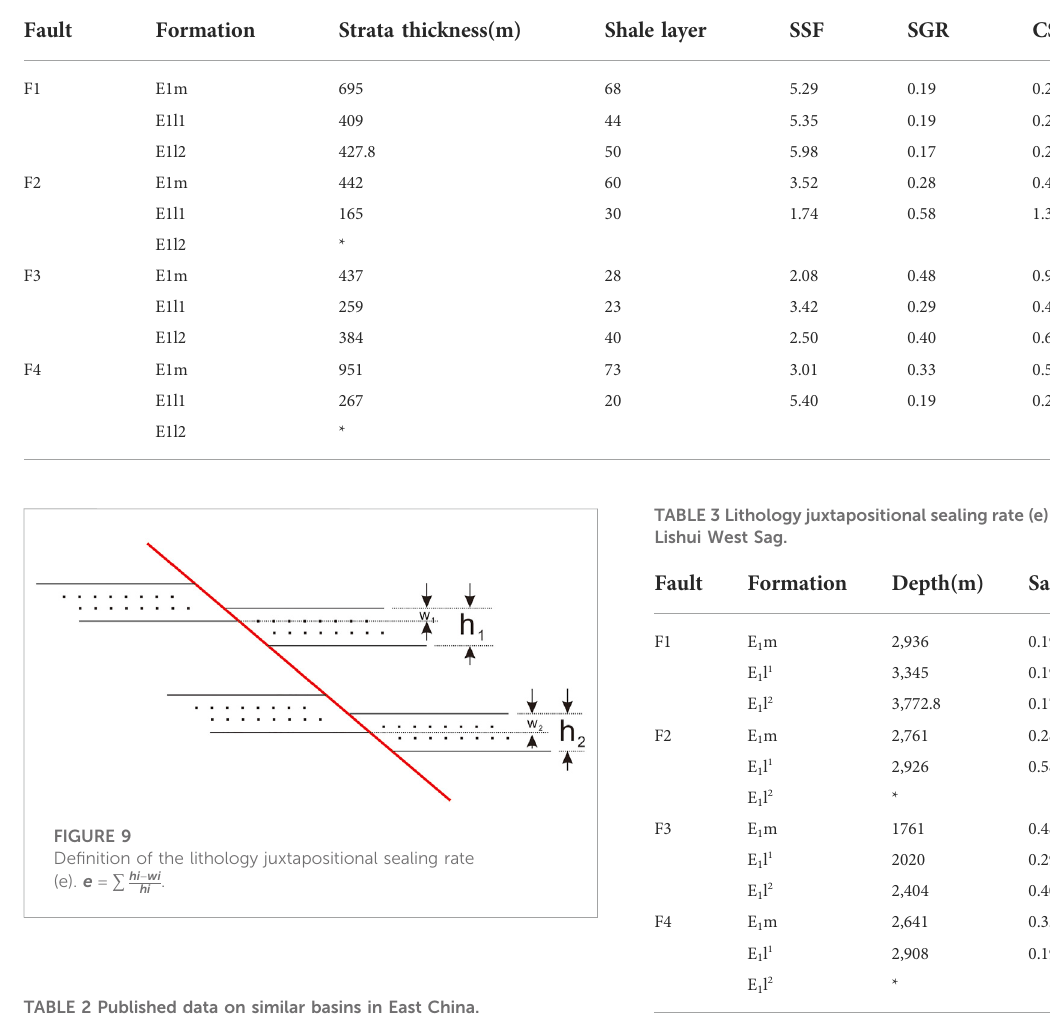
TABLE 1 Shale smear of main faults in the Lishui West Sag.